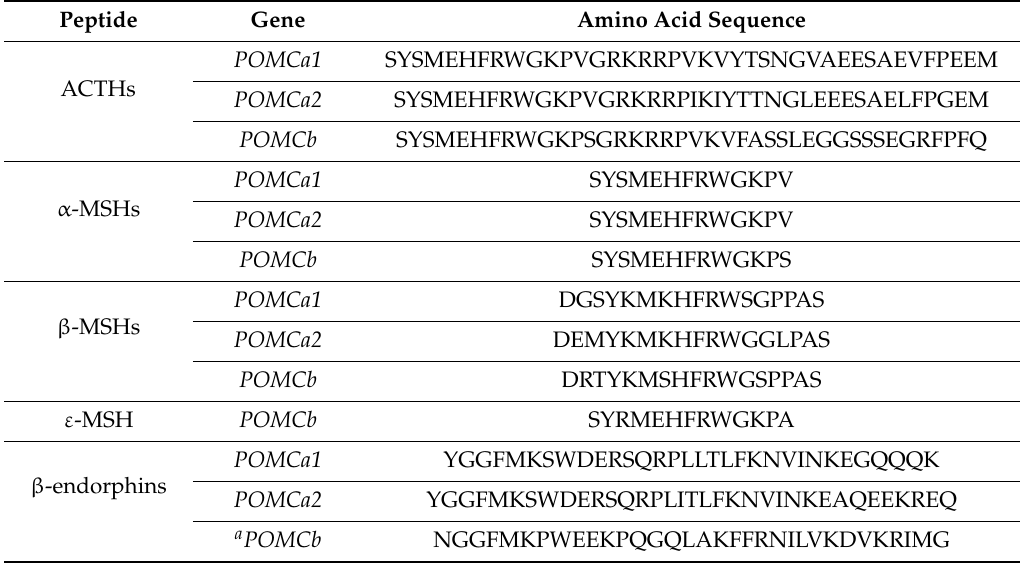
Table 1. Amino acid sequences of peptides derived from three tilapia POMC precursors.